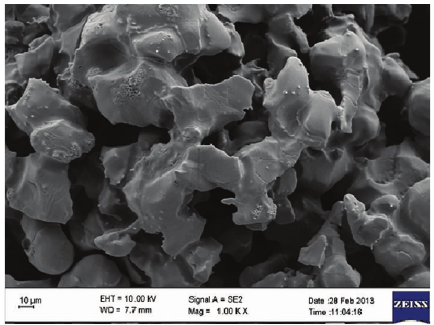
Figure 6: SEM image of ammonium nitrate with 1mL H 4 SiO 4 /5.6 mL H 2 SO 4 and 0.1% calcium lignosulfonate.